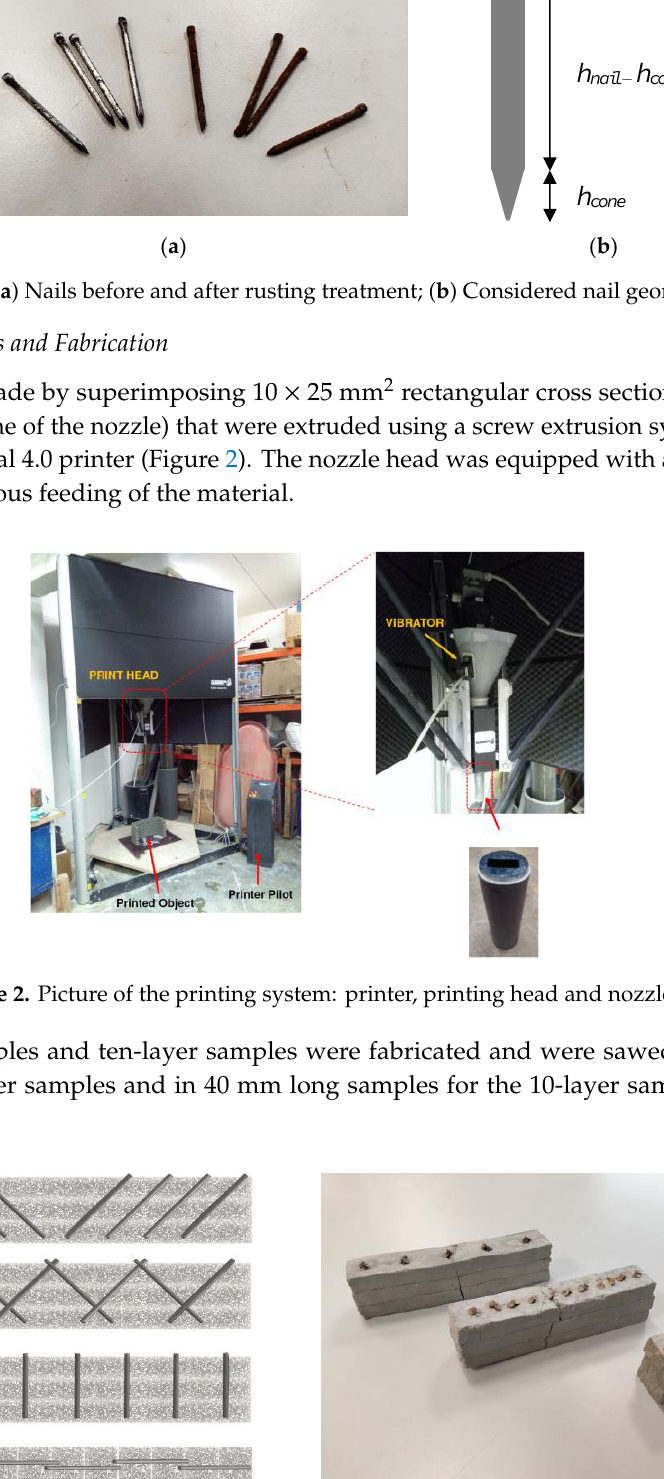
Figure 3. Manufactured samples geometries: ( a ) schematic views; ( b ) pictures of samples after bending tests.